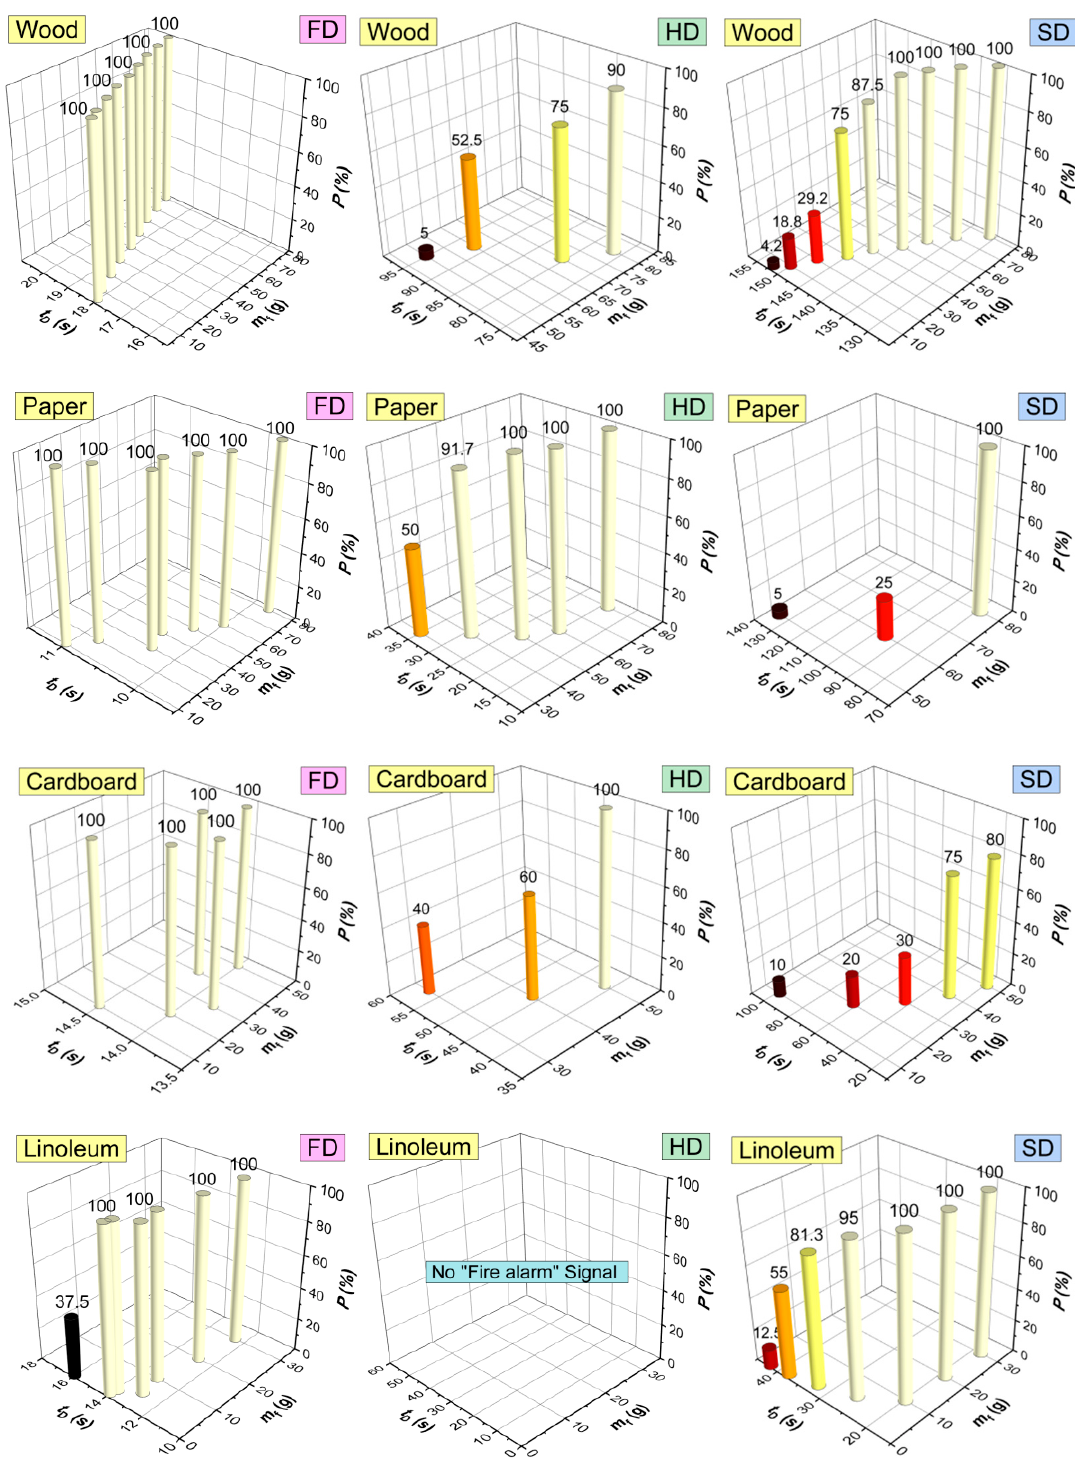
Figure 22. Generalized performance characteristics of fire detectors (FD, HD, SD) for the four combustible materials.